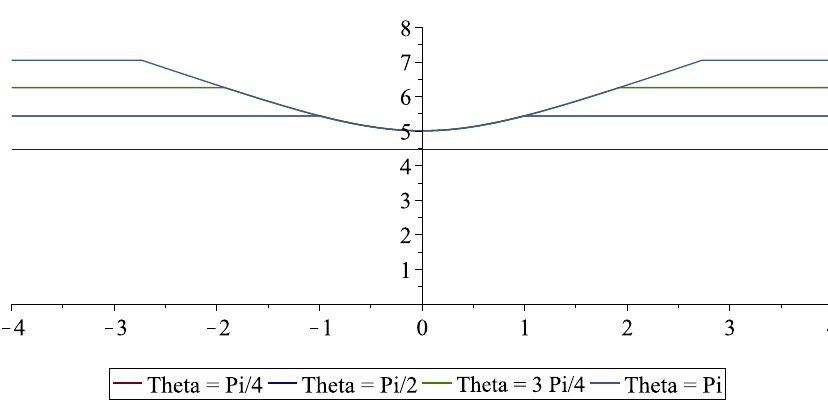
Figure 13 . Regulated entanglement entropy as a function of time for various interval sizes for T = 0 : 5, r H = 2 L AdS , (cid:15) = 0 : 01. Plots from bottom to top show (cid:1) (cid:18) = (cid:25)= 16 ; (cid:25)= 4 ; (cid:25)= 2 ; 3 (cid:25)= 4 ; (cid:25) .